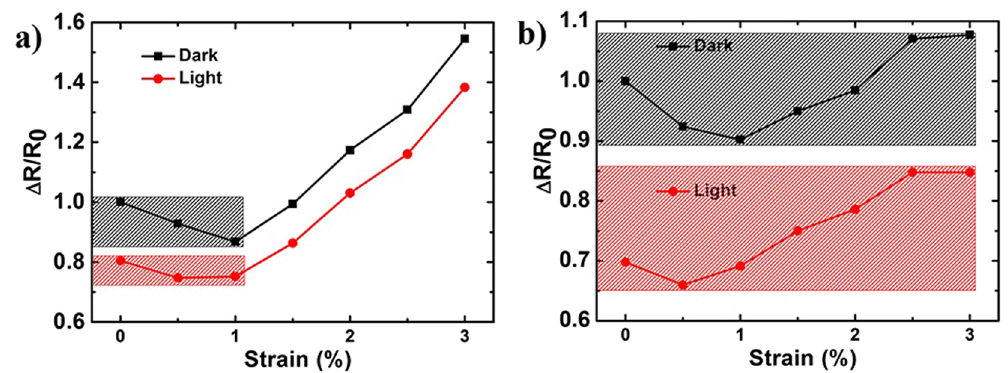
Figure 7. Optoelectronic response under strain for rGO-TiO 2 hybrid system for ( a ) 1-coat and ( b ) 3-coat films. The shaded regions indicate device operation windows where photodetection is possible even in the presence of strain, without incorporating any strain-dependent